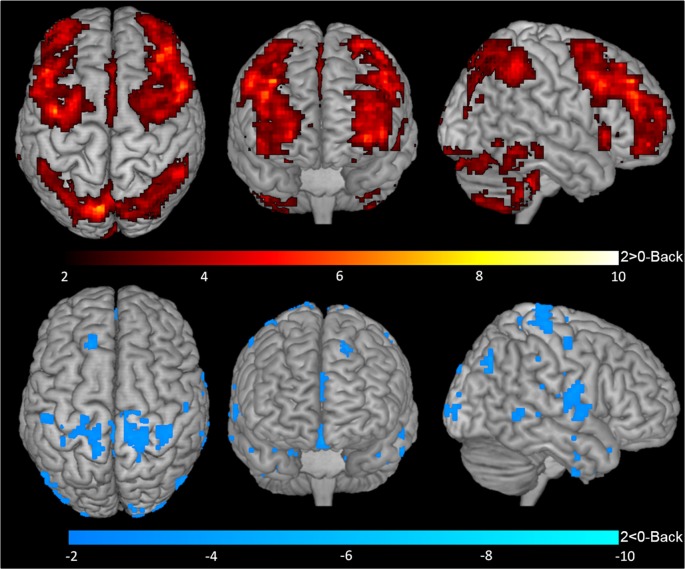
BOLD response during 2-Back performance. Representation of 2-Back performance functional activation (2-Back > 0-Back—top) and deactivation (2-Back < 0-Back—bottom) in axial (left), coronal (middle) and sagittal (right) views. Hotter and colder colors represent respectively increased activation and deactivation.